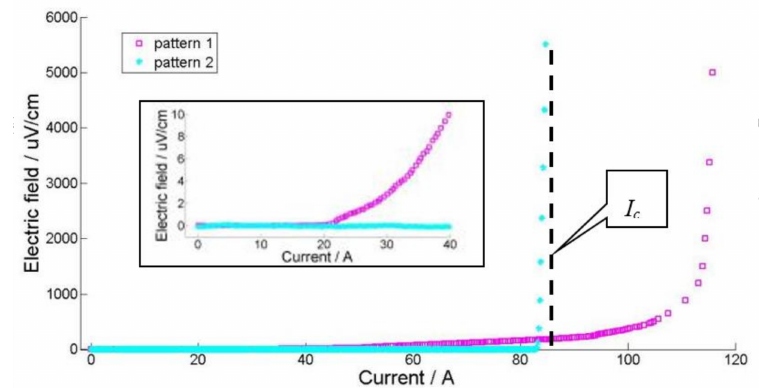
Figure 6. Two type of degradation patterns in E-I curve, pattern 1 is referred to as the resistive pattern, pattern 2 is named the skyrocketing pattern. The zoomed picture shows the transition of pattern 1 from the original point.